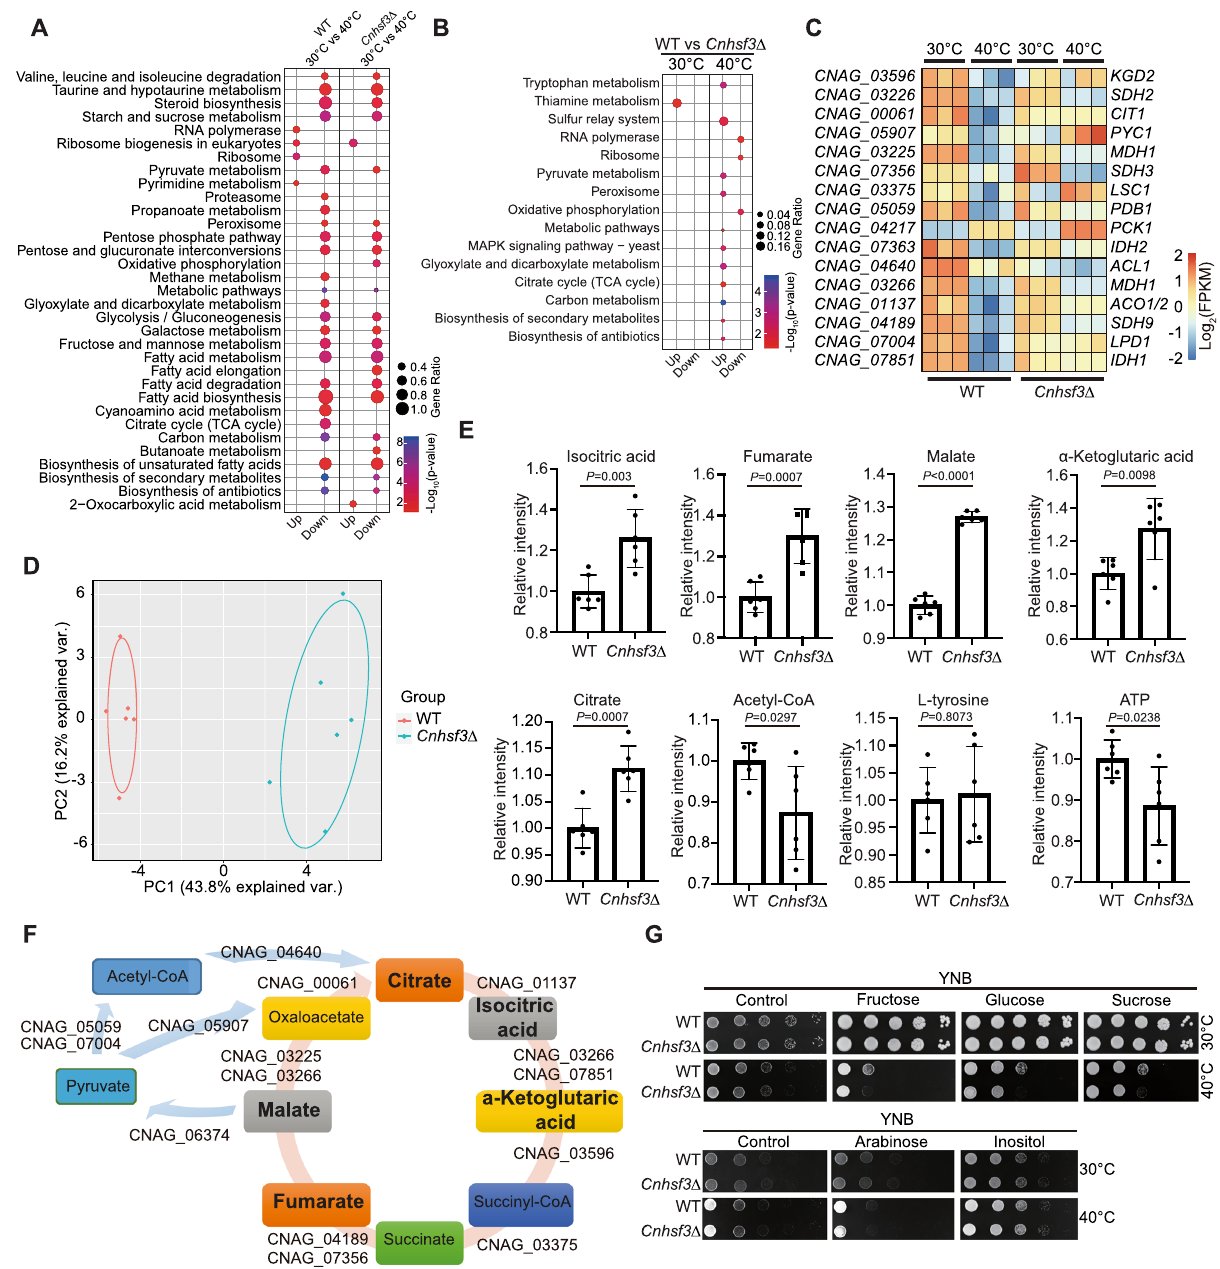
data from wildtype and Cnhsf3 Δ strains. Five TCA cycle intermediates (isocitric acid, fumarate, malate, α -ketoglutaric acid, and citrate), acetyl-CoA, ATP, and L-tyrosine are shown ( n =6). Two-tailed unpaired t -tests were used. F Illustrated metabolome data for the TCA cycle. Key enzymes are shown with gene IDs.